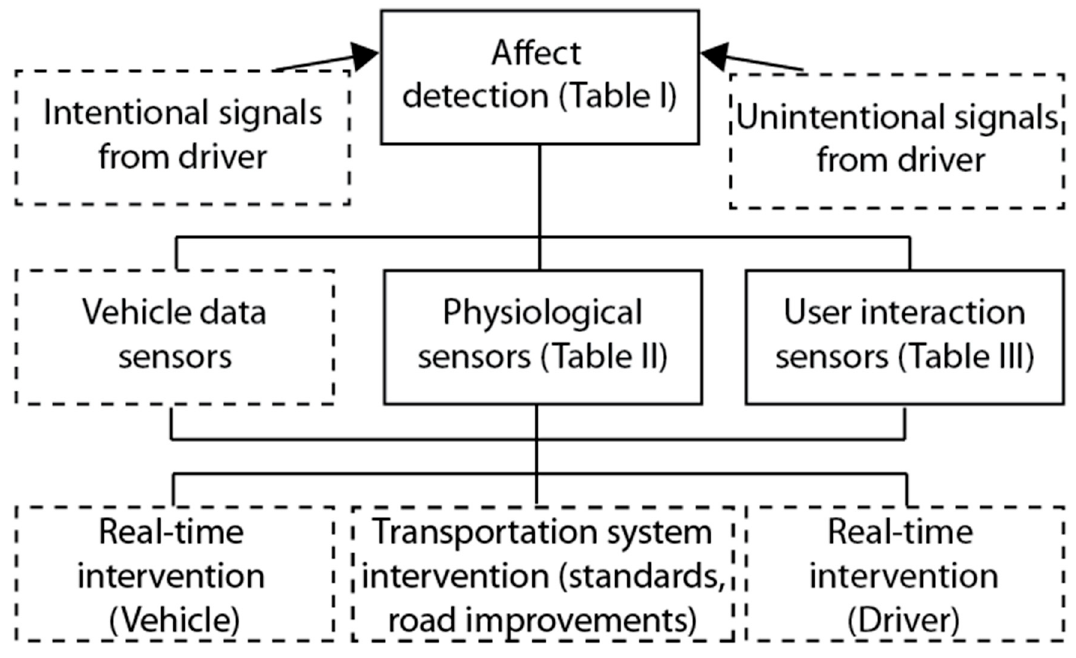
Figure 3. Relationship between driver behavior through intentional and unintentional signals, driver affect detection, sensor types, and safety interventions. Solid borders indicate the topics emphasized in this review.